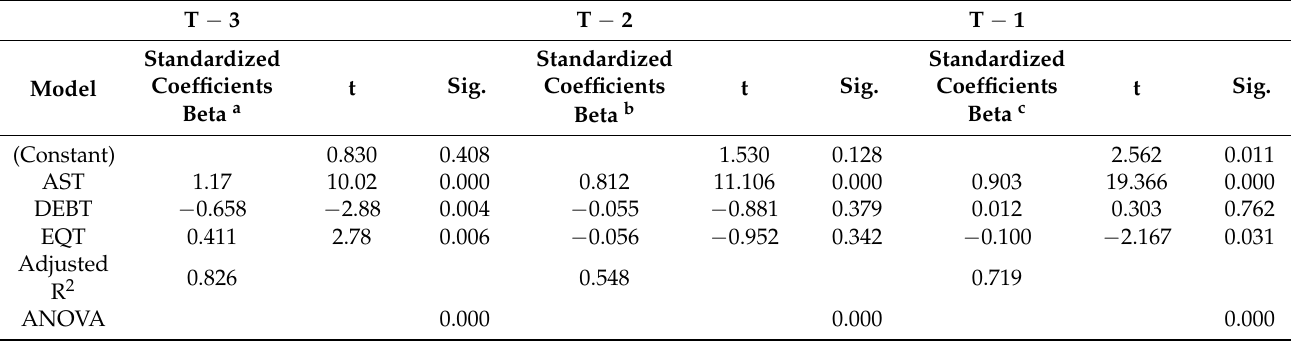
Table 4. Statistics of cash flow of pre-IPO